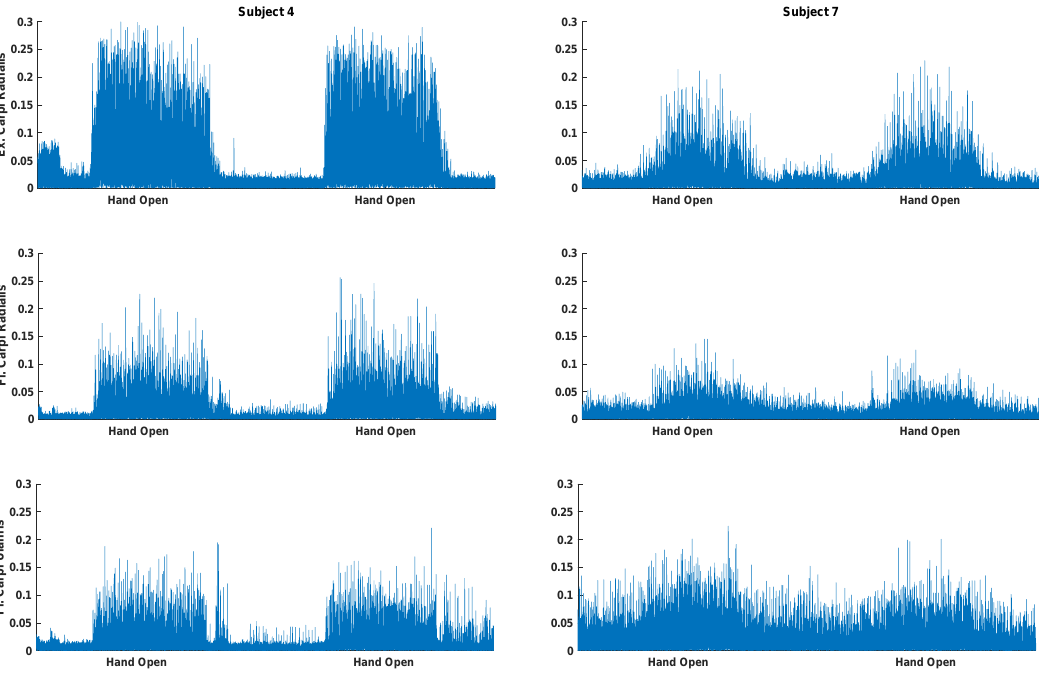
Figure 3. Rectified (only for visualization) and bandpass filtered surface EMG for the Hand Open motion class for the subject with the highest (subject 4) and lowest (subject 7) classification accuracy. The highest and lowest overall classification accuracies were 91% and 54% (classified with linear discriminant analysis), respectively. The amplitude of the EMG for the motions performed by the best subject is higher compared to the worst subject. Moreover, there is a smaller EMG amplitude for the resting state between the movements for the best subject.